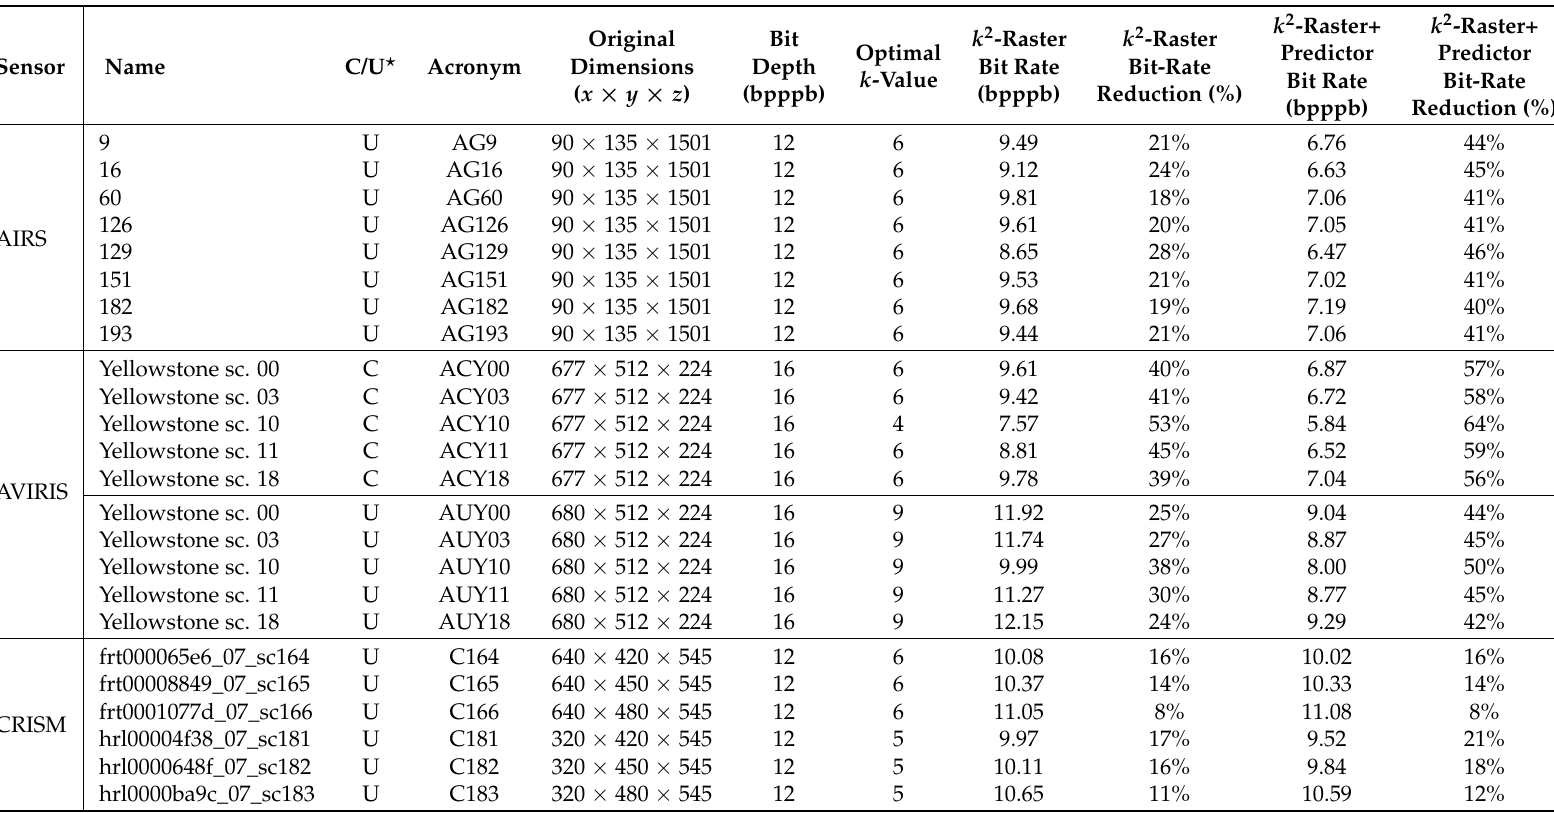
Table 1. Hyperspectral images used in our experiments. It also shows the bit rate and bit rate reduction using k 2 -raster with and without the predictor. x is the image width, y the image height and z the number of spectral bands. The unit bpppb stands for bits per pixel per band.